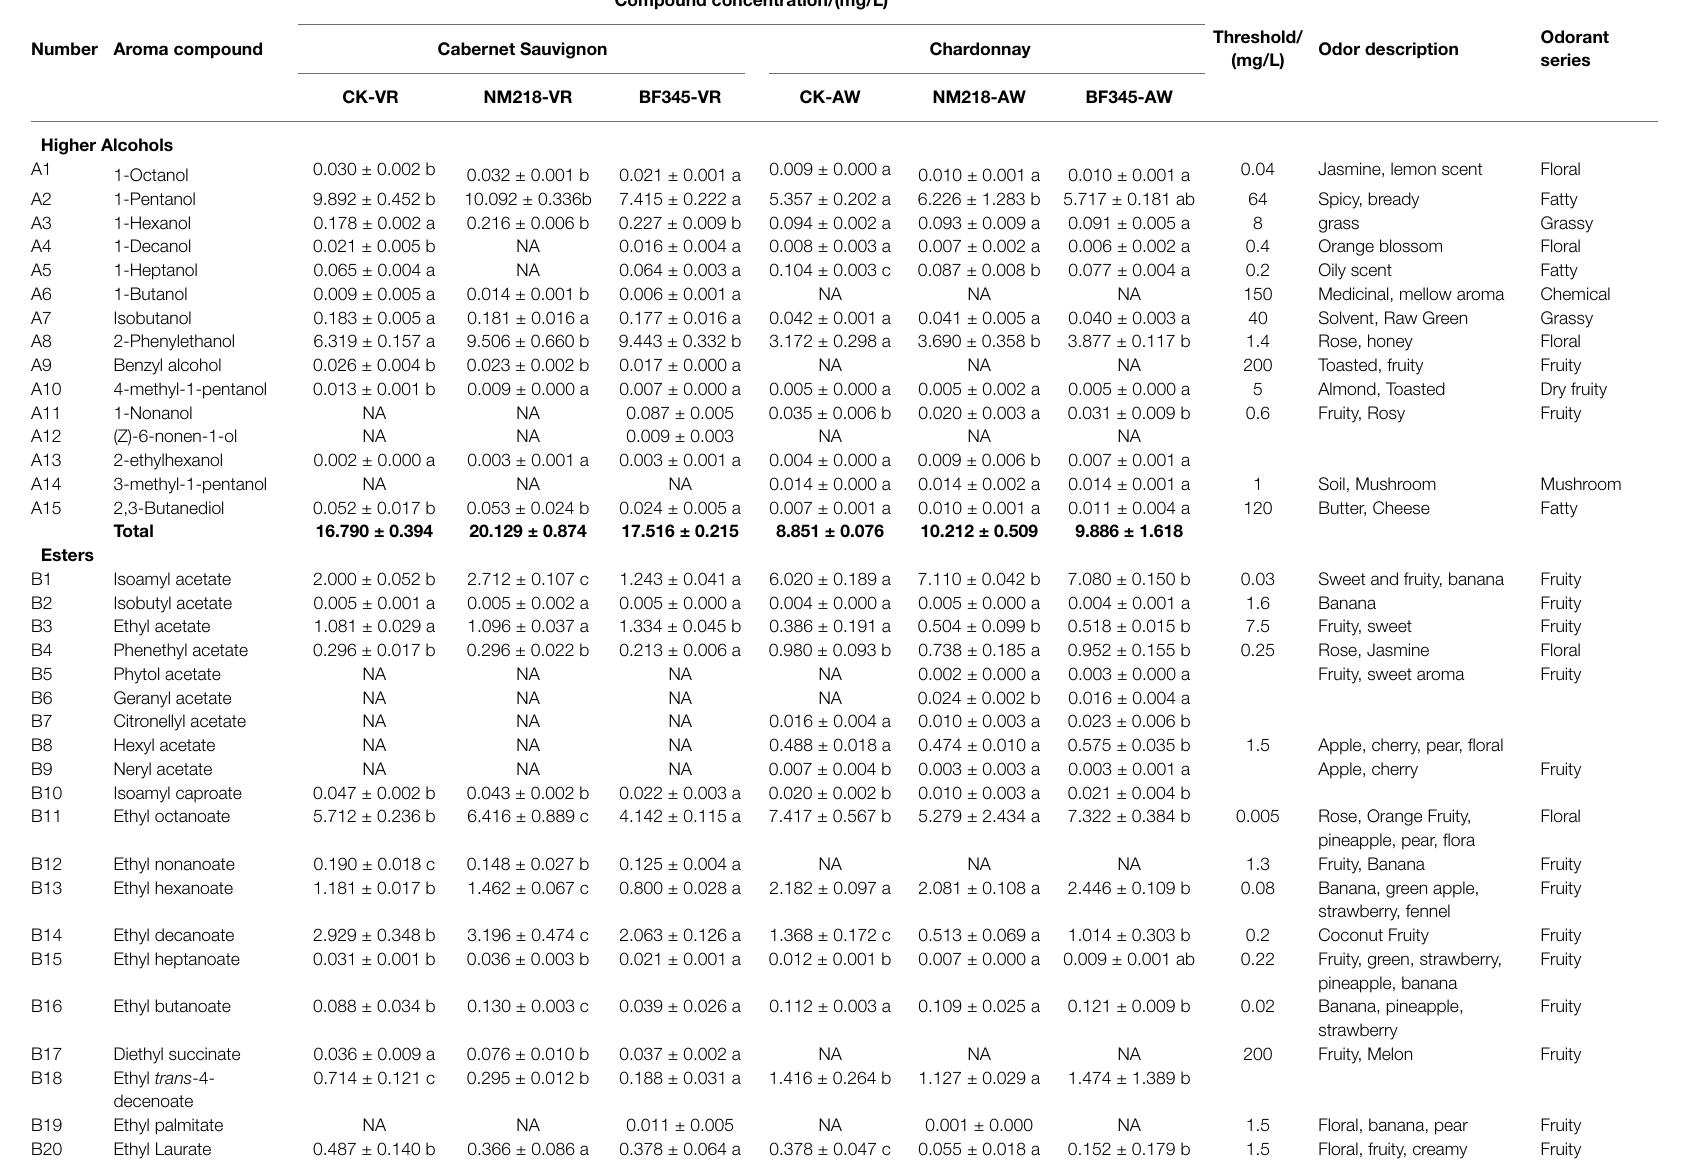
TABLE 2 | Volatile compounds in Cabernet Sauvignon and Chardonnay wines.